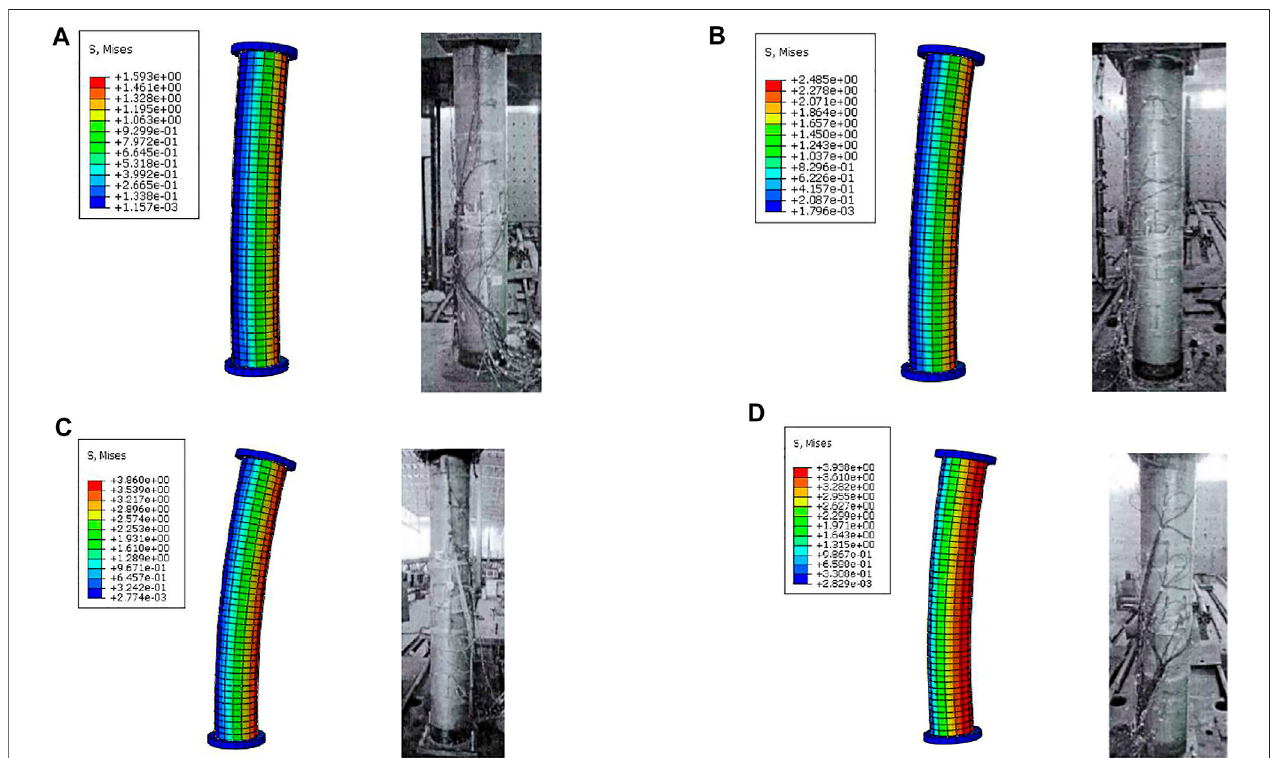
FIGURE8| Comparisonsofdeformationbetweensimulationandtestforfourspecimens. (A) Specimen1-30-10-3. (B) Specimen1-60-10-4. (C) Specimen2-30- 6-3. (D) Specimen 2-60-6-3.